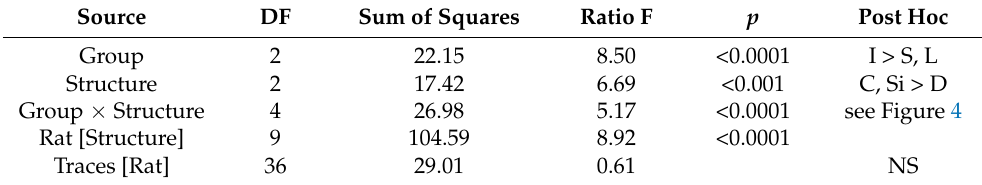
Figure 4. Mean value (mean ± SE) of the maximum amplitude (mV) during horizontal exploration of the Sim B, Crus II structures, and the dentate nucleus (DN) in the intact, sham, and lesion groups. The different letters on the bars (a, b, and c, α = 0.05) indicate contrast in multiple comparisons by Tukey’s method for the means recorded in the groups of rats and structure that were delimited by the effect of the interaction corresponding to the statistical model (Table 2). Table 2. Effects test for horizontal exploration behavior. Results of nested ANOVA for the effect of traces (T), rat (R), structure (S), group (G), and probability of differences based on F values and r 2 = 0.33 of the model. The animals used were made in independent groups.